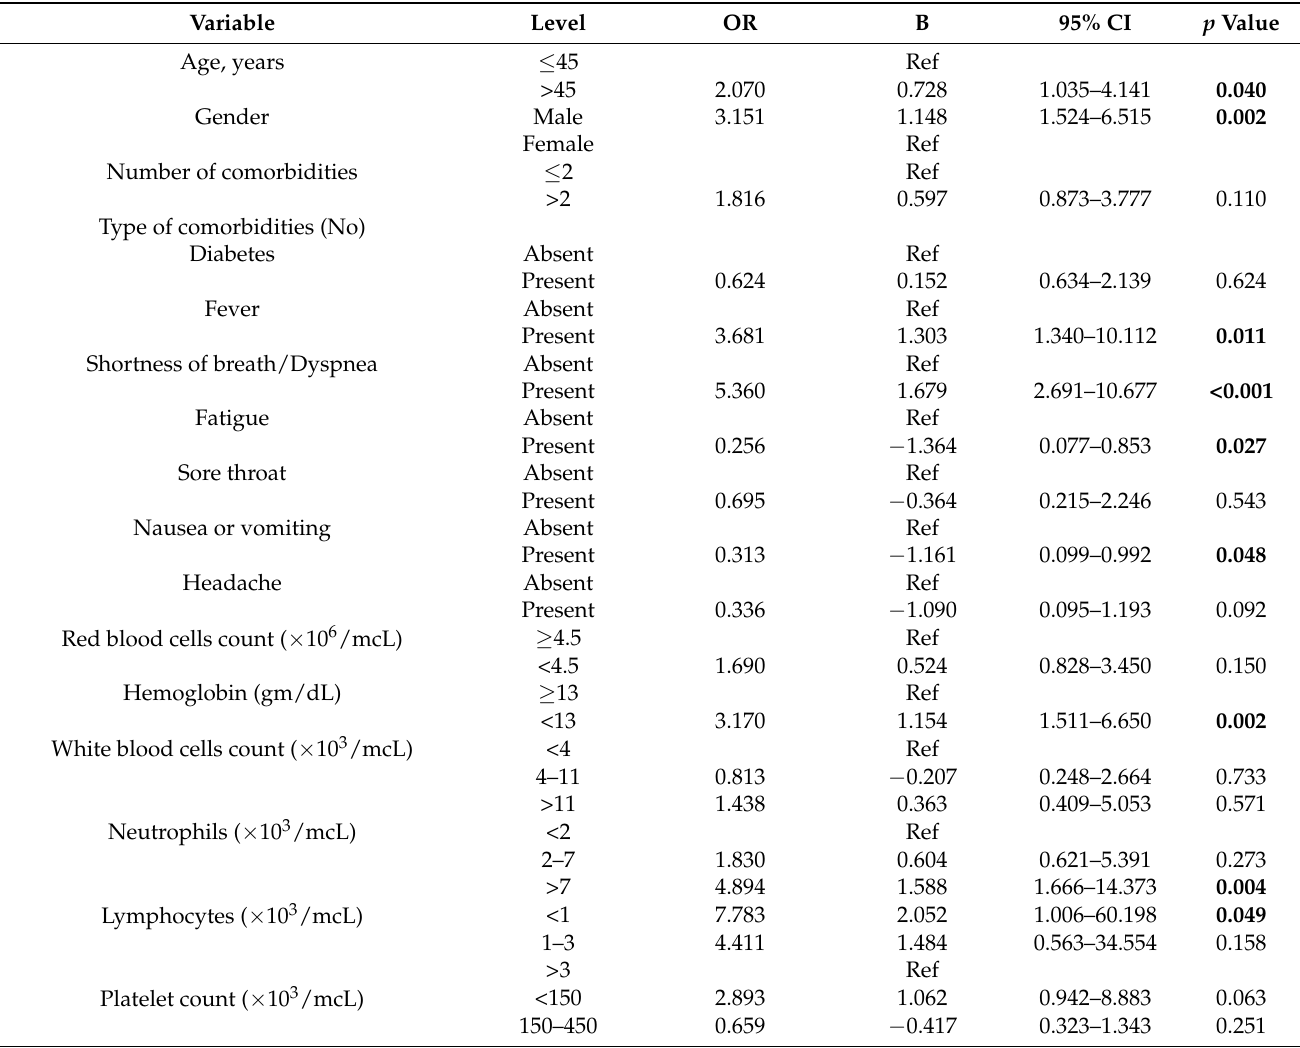
Table 4. Multivariable logistic regression model of the risk factors for severity of